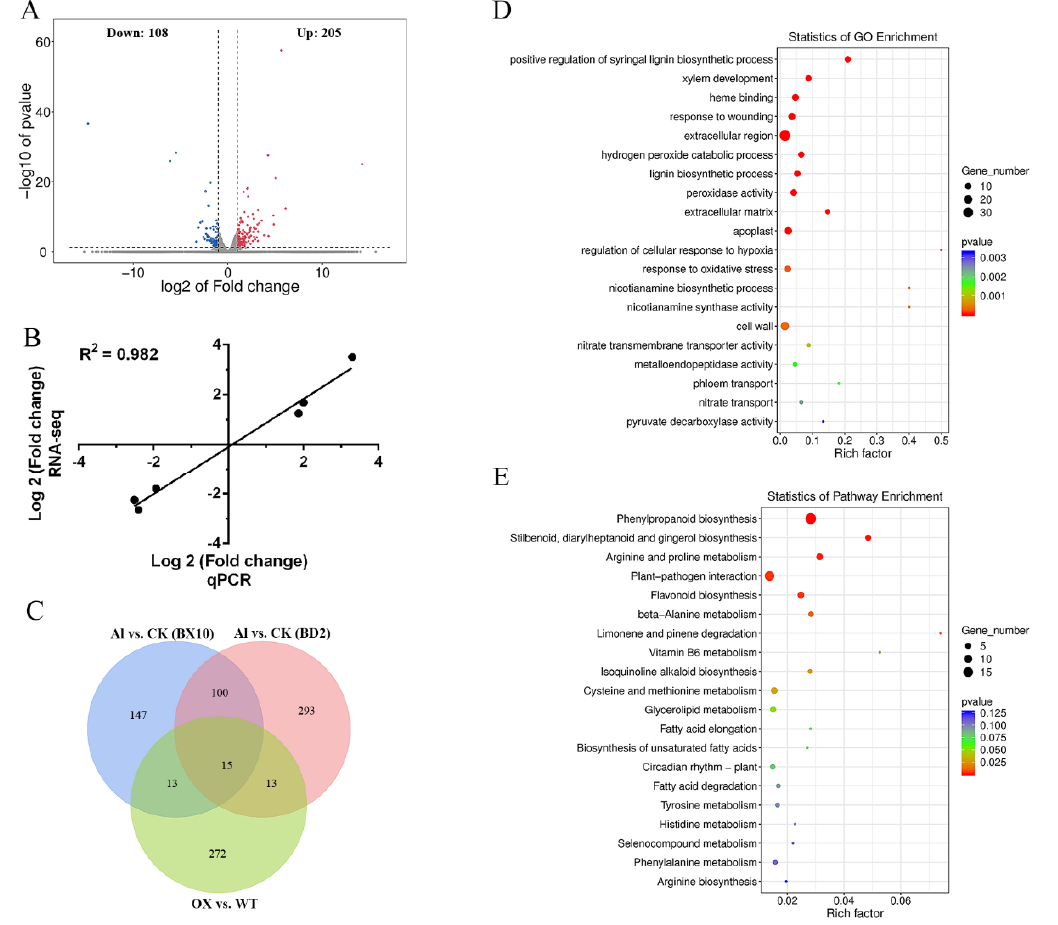
Figure 6. Differentially expressed gene (DEG) identification, gene ontology (GO) enrichment analysis and Kyoto Encyclopedia of Genes and Genomes (KEGG) enrichment analysis. ( A ) Scatter plot of DEGs between transgenic lines and WT. The red dots and blue dots represent up- and downregulated genes, respectively. ( B ) Correlation analysis between qPCR and RNA-seq results. ( C ) Venn plots of DEGs induced by Al in Baxi10 (BX10) (blue), Bendi2 (BD2) (pink) and GmWRKY81-overexpressing lines (green); the numbers represent the quantities of DEGs; fifteen shared DEGs are shown in the overlapping region. ( D ) The result of GO enrichment analysis. The diameter and color depth of each circle are positively correlated with the number of enriched genes and significance level, respectively. ( E ) The result of KEGG enrichment analysis. The diameter and color depth of each circle are positively correlated with the number of enriched genes and significance level,